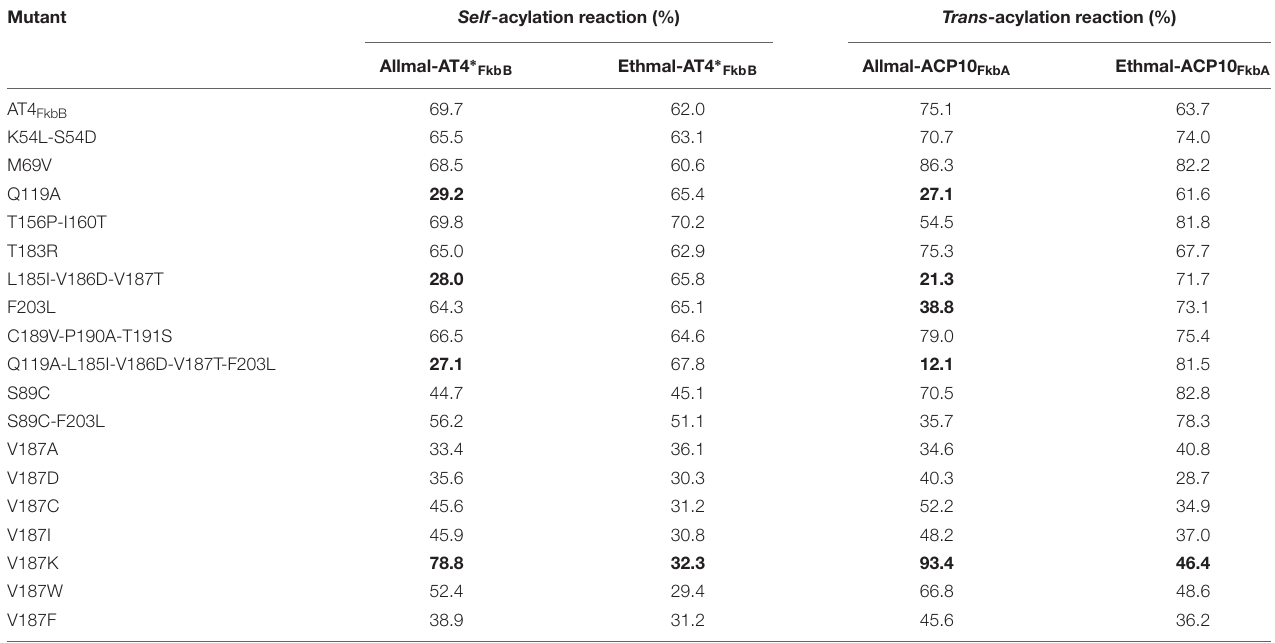
TABLE 1 | The activities of AT4 FkbB and its mutants of Fk506 PKS with allmal- or ethmal-CoA as the substrate in self - and trans -acylation reactions. Mutant Self -acylation reaction